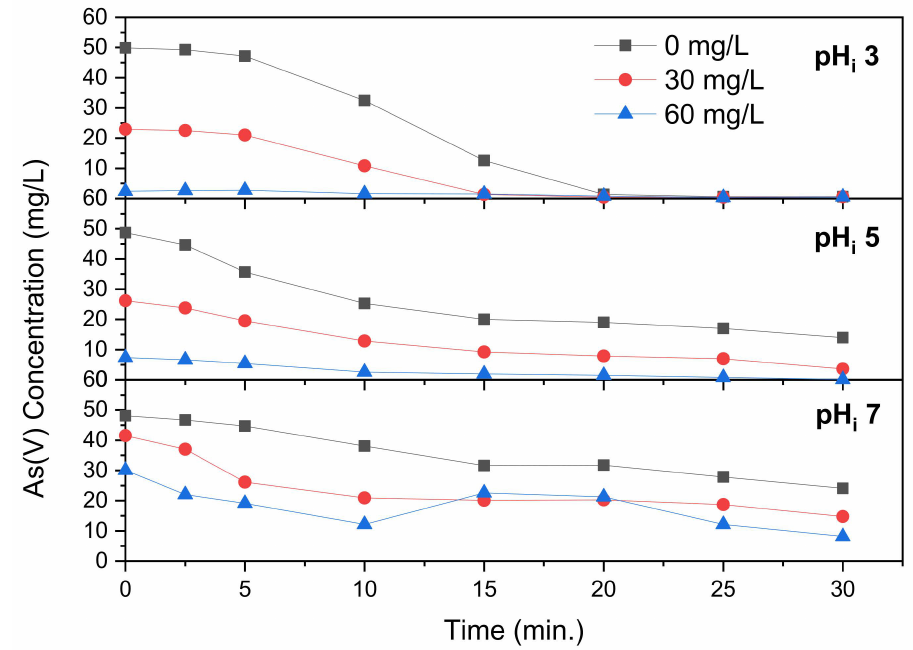
Figure 5. Arsenic removal over time through electrocoagulation assisted by varying concentrations of Fe(III) addition.